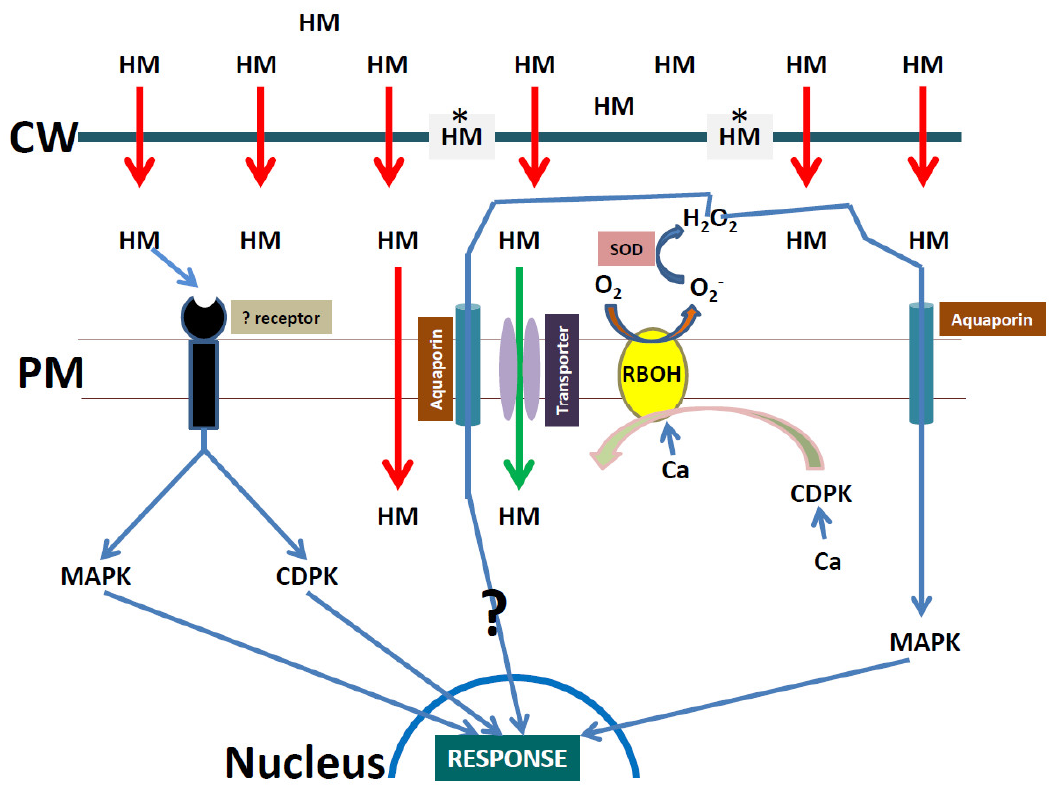
Figure 2. Scheme showing a putative heavy metal (HM) stress signaling cascade in plants. HMs move from outside the root through the cell wall (CW) into the apoplast by passive diffusion (red arrow). Some of the HMs are trapped (*) at the CW, but the apoplastic HMs can trigger the response of an unknown receptor, or actively move into the symplast via HM transporters (green arrow) located at the PM. HMs can also move through the PM via passive diffusion (red arrow). The unknown receptor signals responses to activate MAPK and CDPK, respectively, which can trigger a nuclear response. CDPK through calcium (Ca) activation phosphorylates NADPH oxidase (RBOH) in the presence of